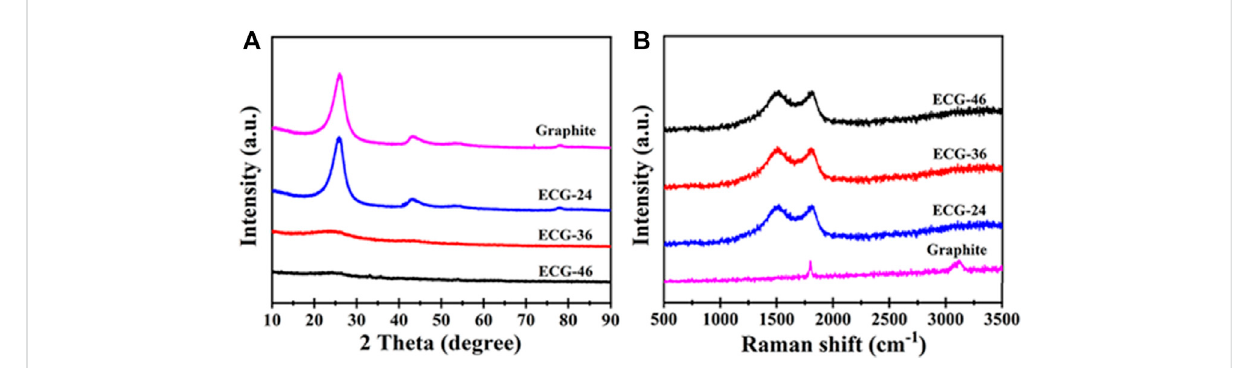
FIGURE 3 (A) Diffraction patterns and (B) Raman spectra of pristine graphite and ECG